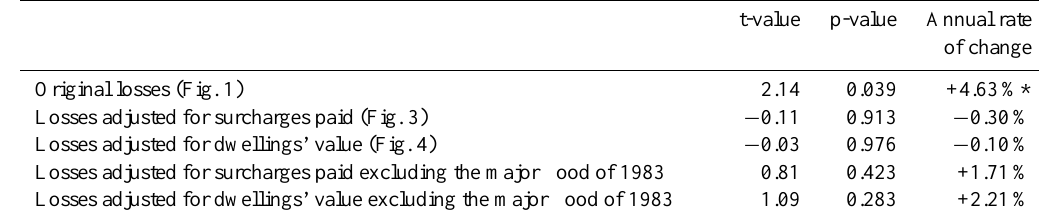
Table 1. Annual rate of change in the series of losses and test of statistical significance. t-value p-value Annual rate of change Original losses (Fig. 1) 2.14 0.039 +4.63%* Losses adjusted for surcharges paid (Fig. 3) − 0.11 0.913 − 0.30% Losses adjusted for dwellings’ value (Fig. 4) − 0.03 0.976 − 0.10% Losses adjusted for surcharges paid excluding the major flood of 1983 0.81 0.423 +1.71% Losses adjusted for dwellings’ value excluding the major flood of 1983 1.09 0.283